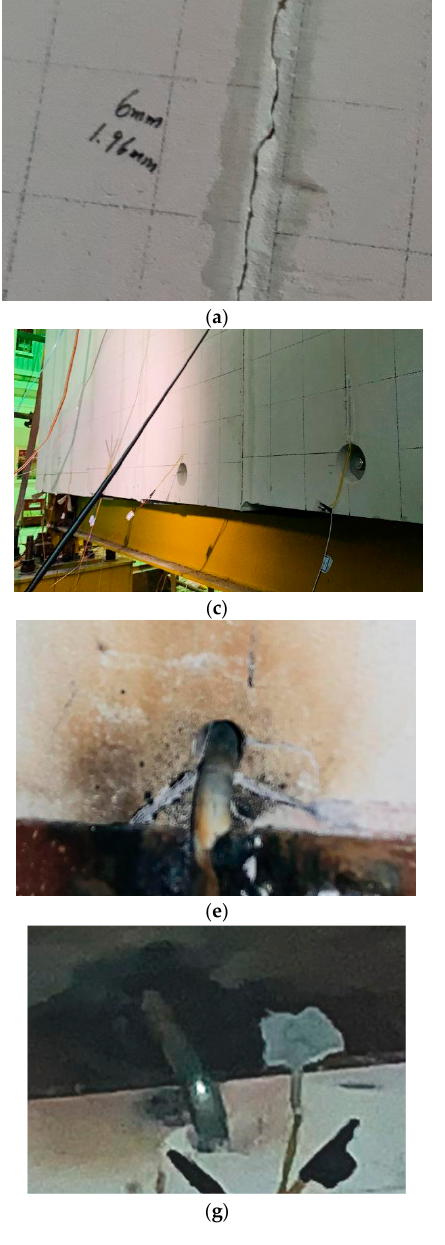
Figure 8. Experimental results of SFW1: ( a ) cracks appeared in the joint mortar panel joint; ( b ) ALC debris falling off; ( c ) obvious dislocation between panel; ( d ) angle steel weld fracture; ( e ) extended cracks at bolt holes; ( f ) the broken phenomenon of the panel angle; ( g ) the upper bolt holes expand and bolt wobbled; ( h ) weld fracture.